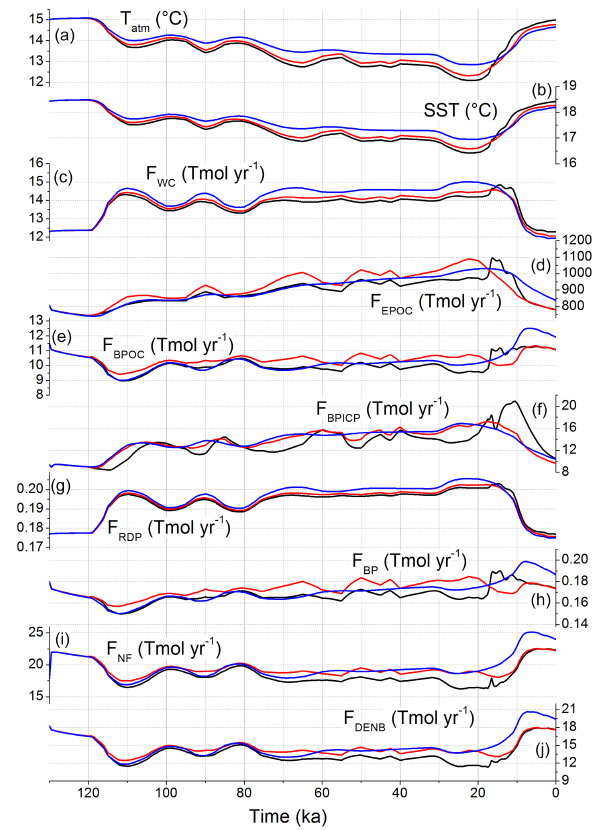
Figure 6. Model results for simulations STD (black lines), STD-CC (red lines), and STD-CC-CN (blue lines). (a) Global mean atmo- spheric near-surface temperature ( T atm ); (b) global mean sea sur- face temperature (SST); (c–j) global rates: (c) carbonate weather- ing ( F WC ); (d) marine export production of POC ( F EPOC ); (e) POC burial ( F BPOC ); (f) burial of pelagic carbonate ( F BPICP ); (g) river- ine flux of dissolved phosphorus ( F RDP ); (h) burial of marine phos- phorus ( F BP ); (i) nitrogen fixation ( F NF ); (j) benthic denitrification ( F DENB ).